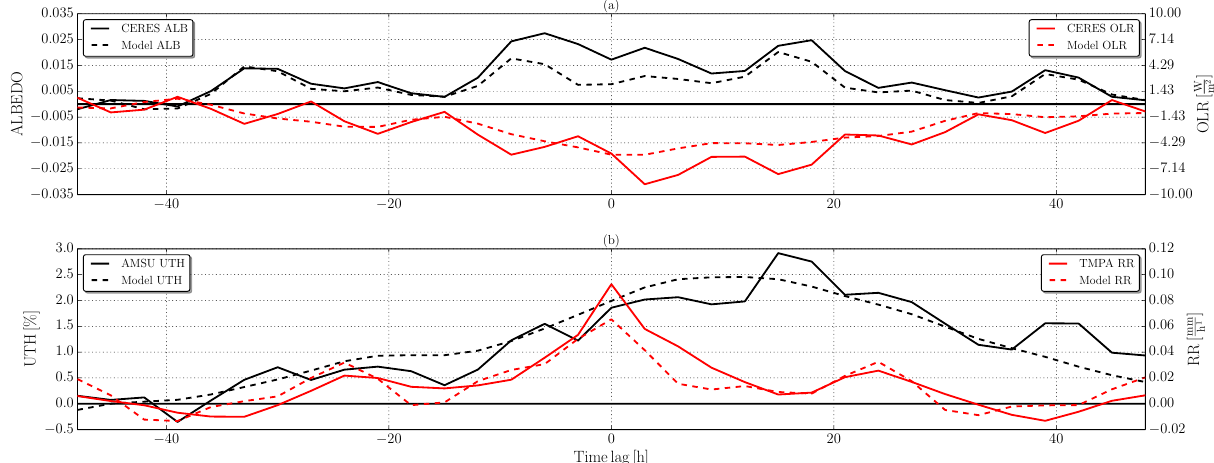
Fig. 5. Observed (solid) and modelled (dashed) anomalies in albedo, OLR, UTH, and RR, averaged over a region spanning ± 6 . 5 ◦ latitude and ± 10 . 5 ◦ longitude of the composite centre point. The background state (i.e. the zero level) is taken as the average of − 48h to −